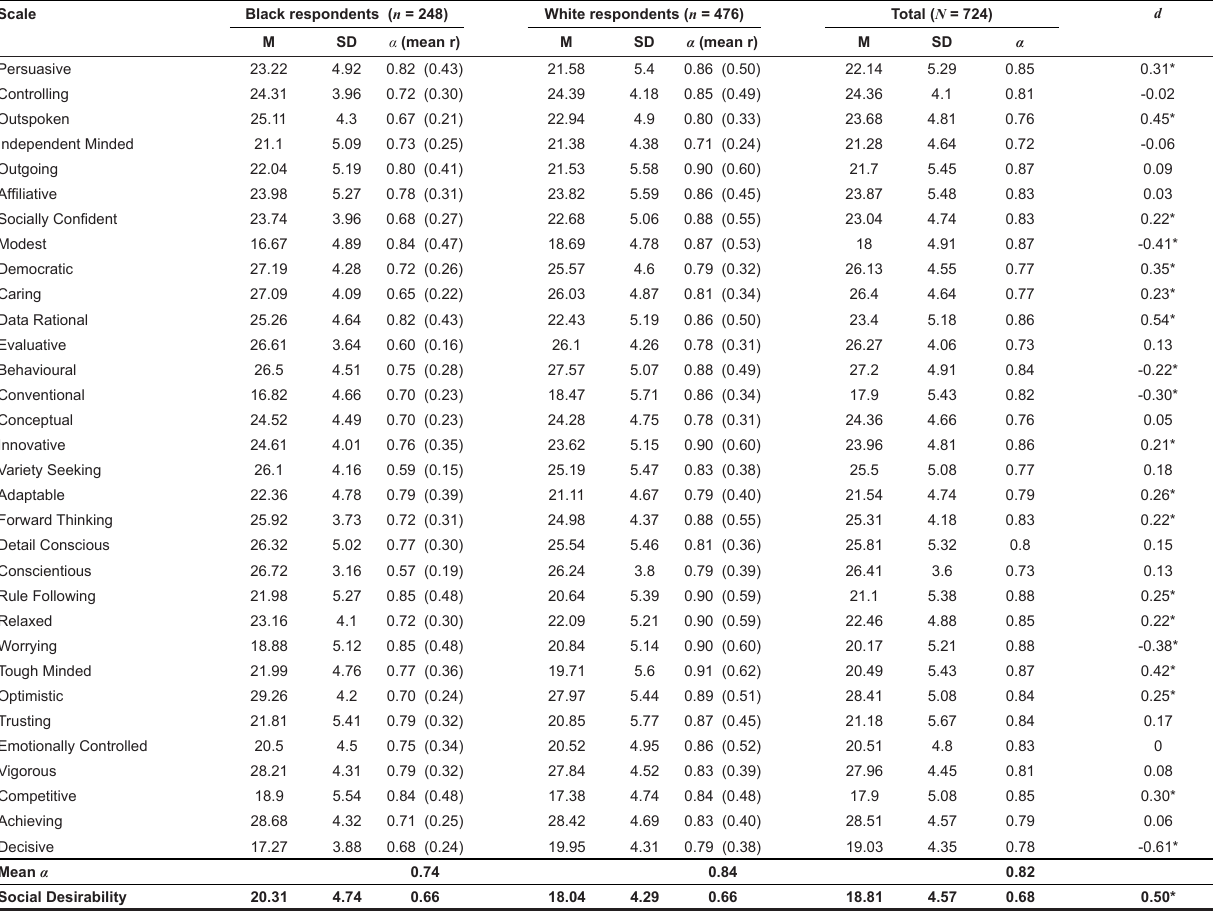
Table 2 Means, standard deviations, alpha coefficients and d statistics for the Black and White